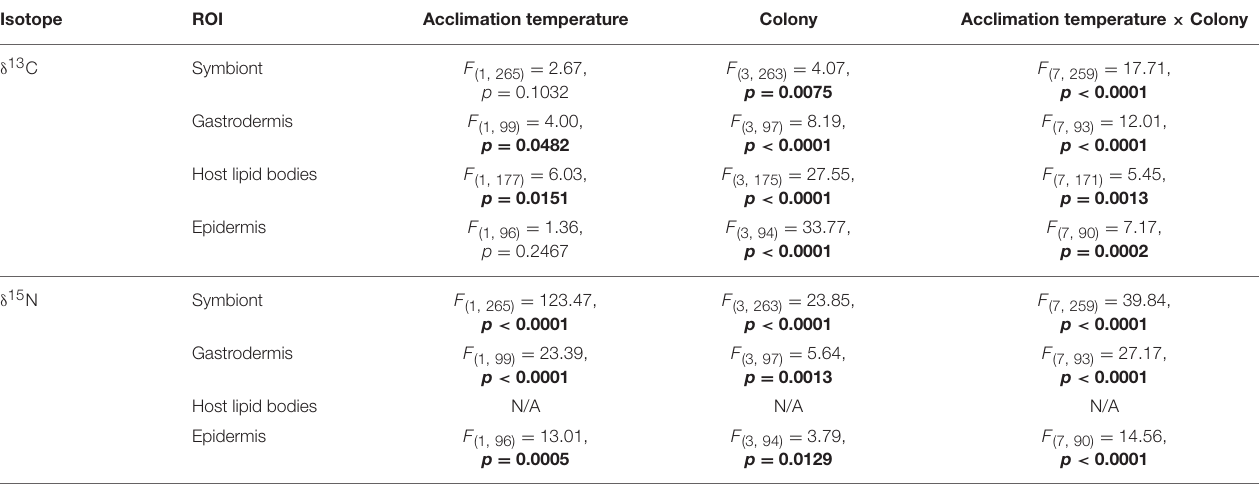
TABLE 1 | The effect of acclimation temperature on carbon and nitrogen assimilation rates in Pocillopora damicornis at the end of a 7-day heat stress event. Statistical output of rmANOVA ( n = 4), using acclimation temperature (ambient or warm) and colony (matched pairs) as factors. Isotope ROI Acclimation temperature